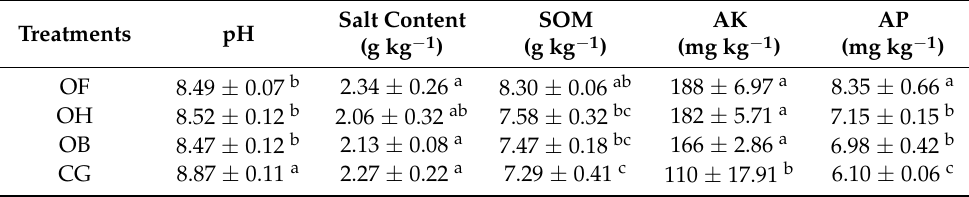
Table 3. Variation of chemical properties between different treatments in 0–20 cm layer. Salt Treatments pH